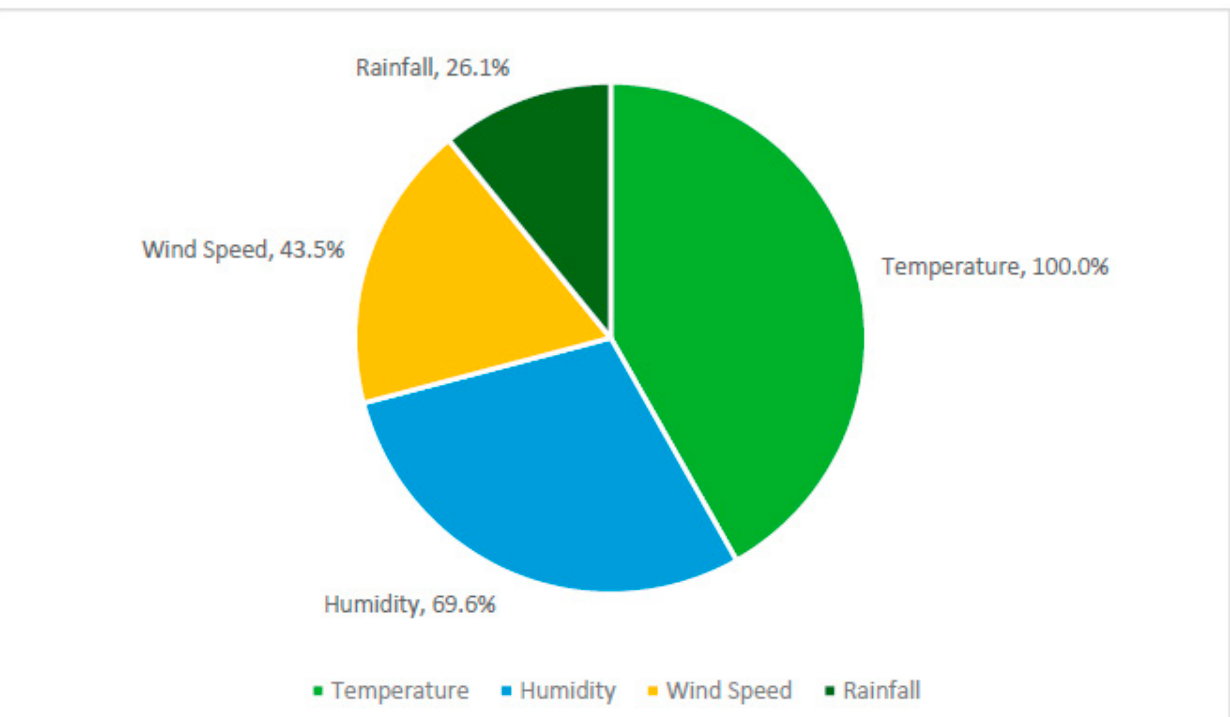
Figure 4. Percentage of studies, including Temperature, Humidity, Wind speed or Rainfall weather variables.